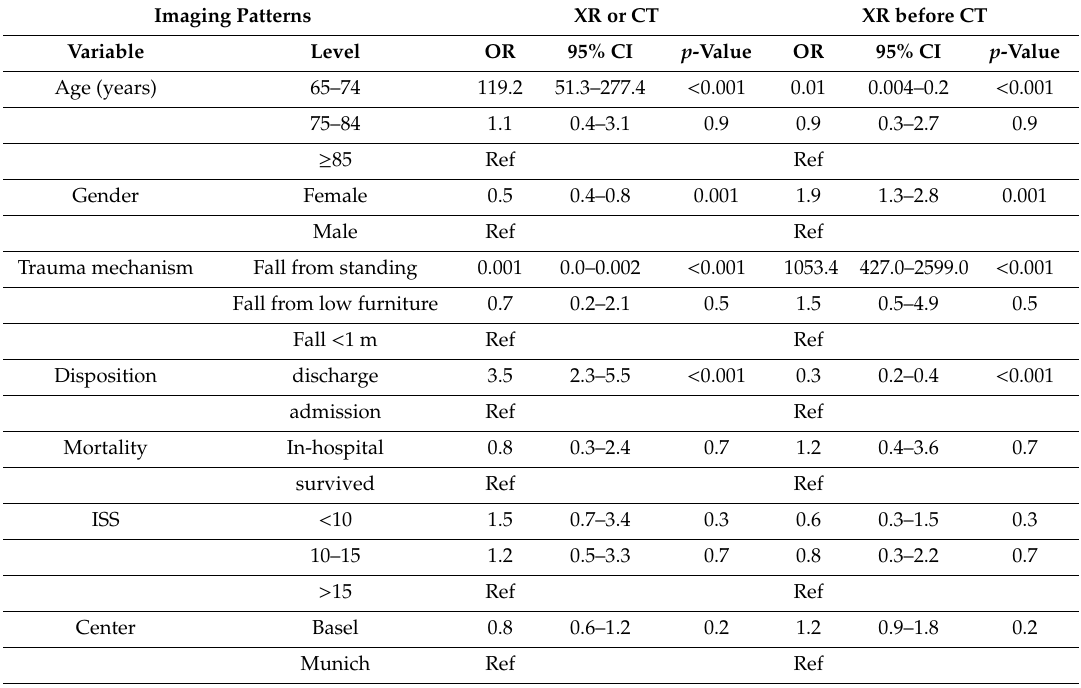
Table 2. Binary logistic regression of performing XR or CT separate or XR before CT